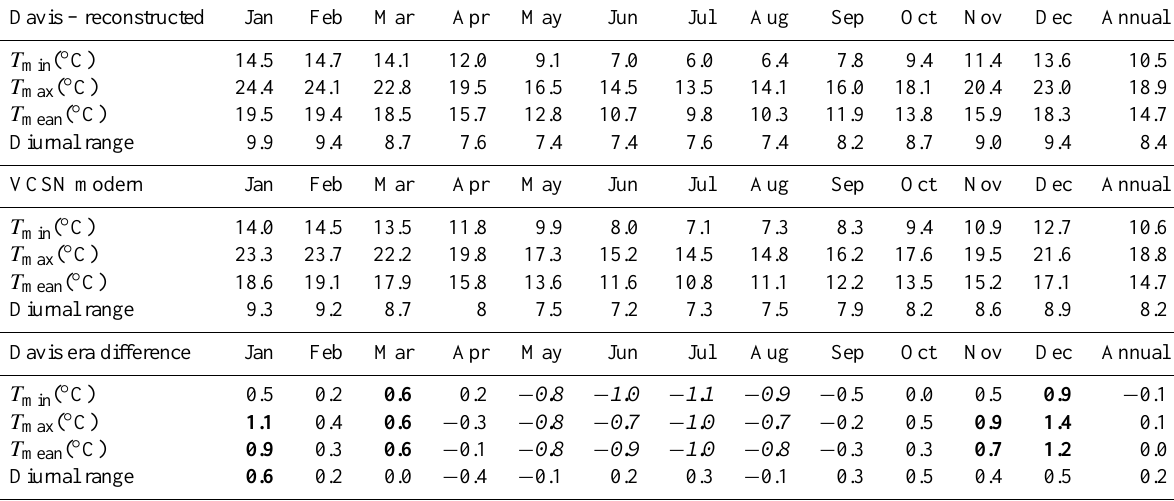
Table 3. VCSN-equivalent average monthly T min , T max , T mean and diurnal temperature range based on Reverend Davis 9a.m. and noon temperatures compared to modern climatology (for 1972–2012). Bold (italic) highlighting indicates warmer (colder) differences of more than 0.5 ◦ C for Davis observations relative to the present.